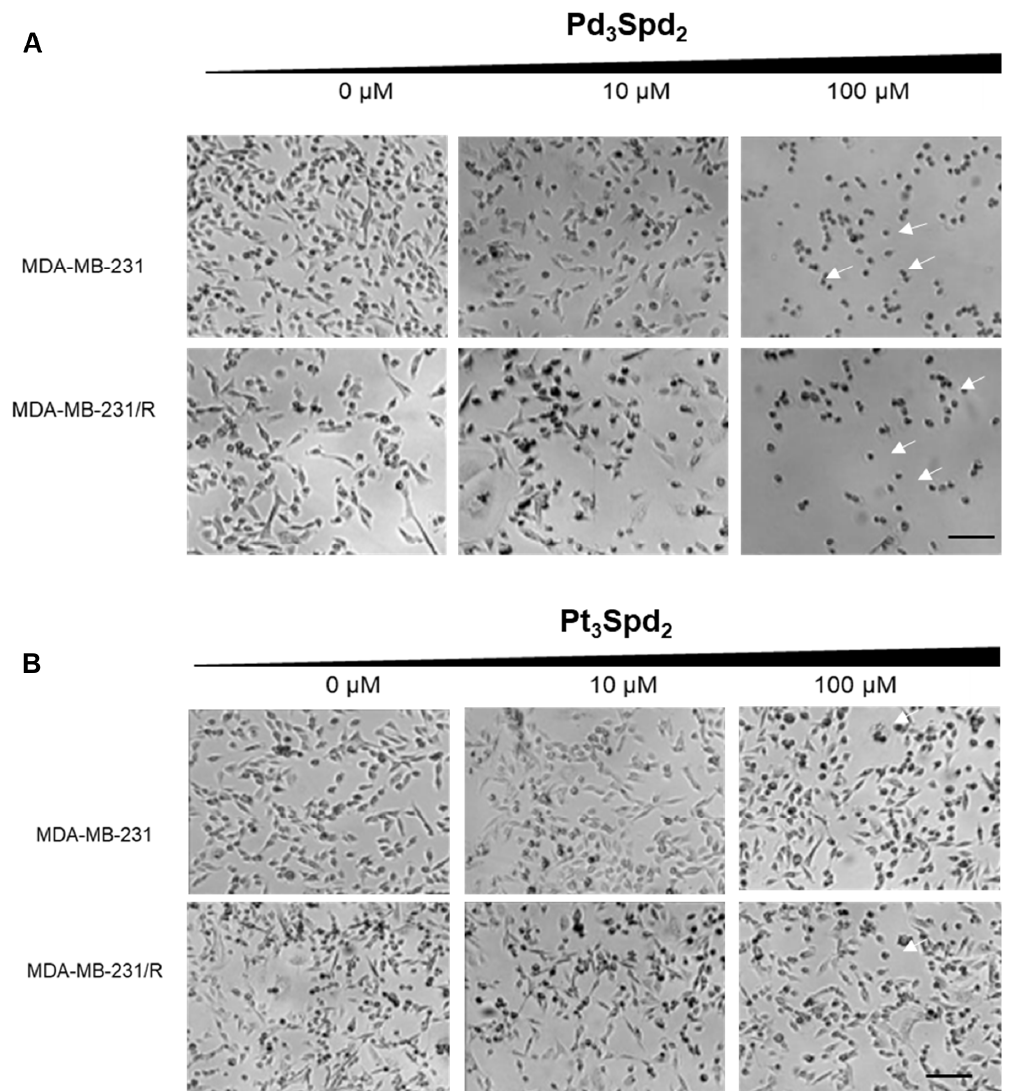
Figure 3. Representative photomicrographs with morphological features induced by increasing concentrations of Pd 3 Spd 2 ( A ) or Pt 3 Spd 2 ( B ) incubated for 48 h in MDA-MB-231 cells or MDA-MB-231/R cells. White arrows show cytoplasmic shrinkage and the rounding of cells. Representative images from 4 independent experiments obtained under an objective lens of a phase contrast of the LionheartFX microscope. Scale bar = 100 µm. Table 2. Half-maximal inhibitory concentration (IC 50 ) of Pd 3 Spd 2 or Pt 3 Spd 2 against MDA-MB-231 and MDA-MB-231/R cells at 24, 48 and 72 h of incubation regarding cell viability measurements.